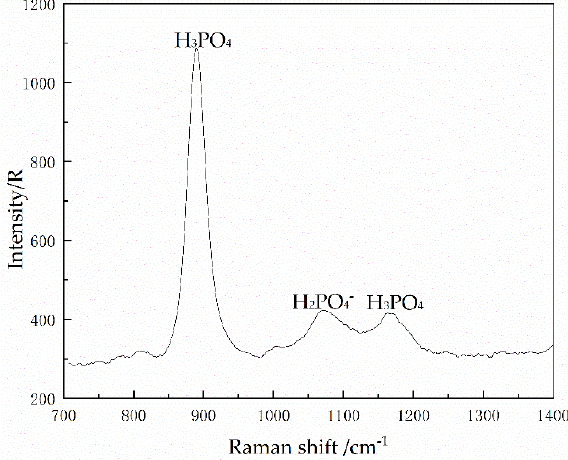
Figure 5. Raman spectroscopy pattern of the leaching solution.